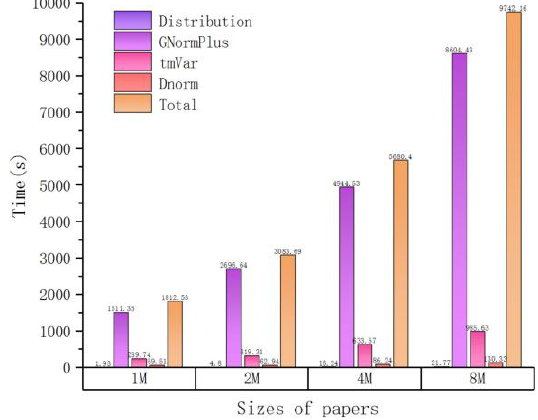
Figure 2. The time cost of processing different input sizes in serial. Table 3. Time cost distribution of processing different input sizes in serial.